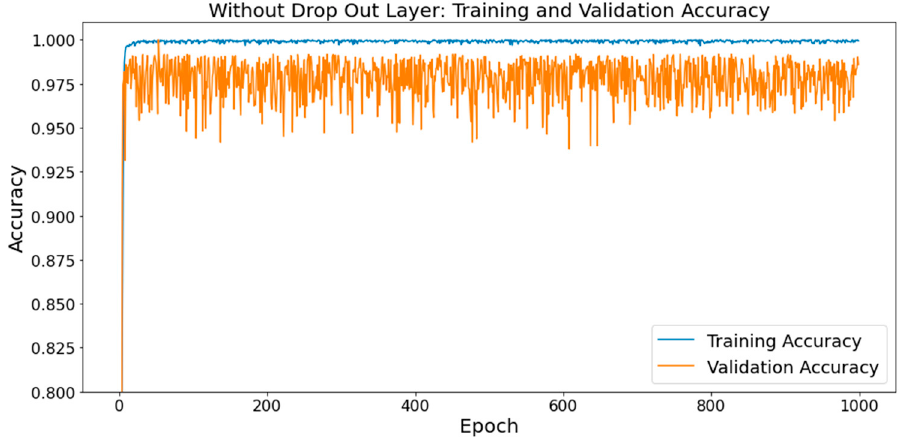
Figure 7. The accuracy of training and validation sets without dropout